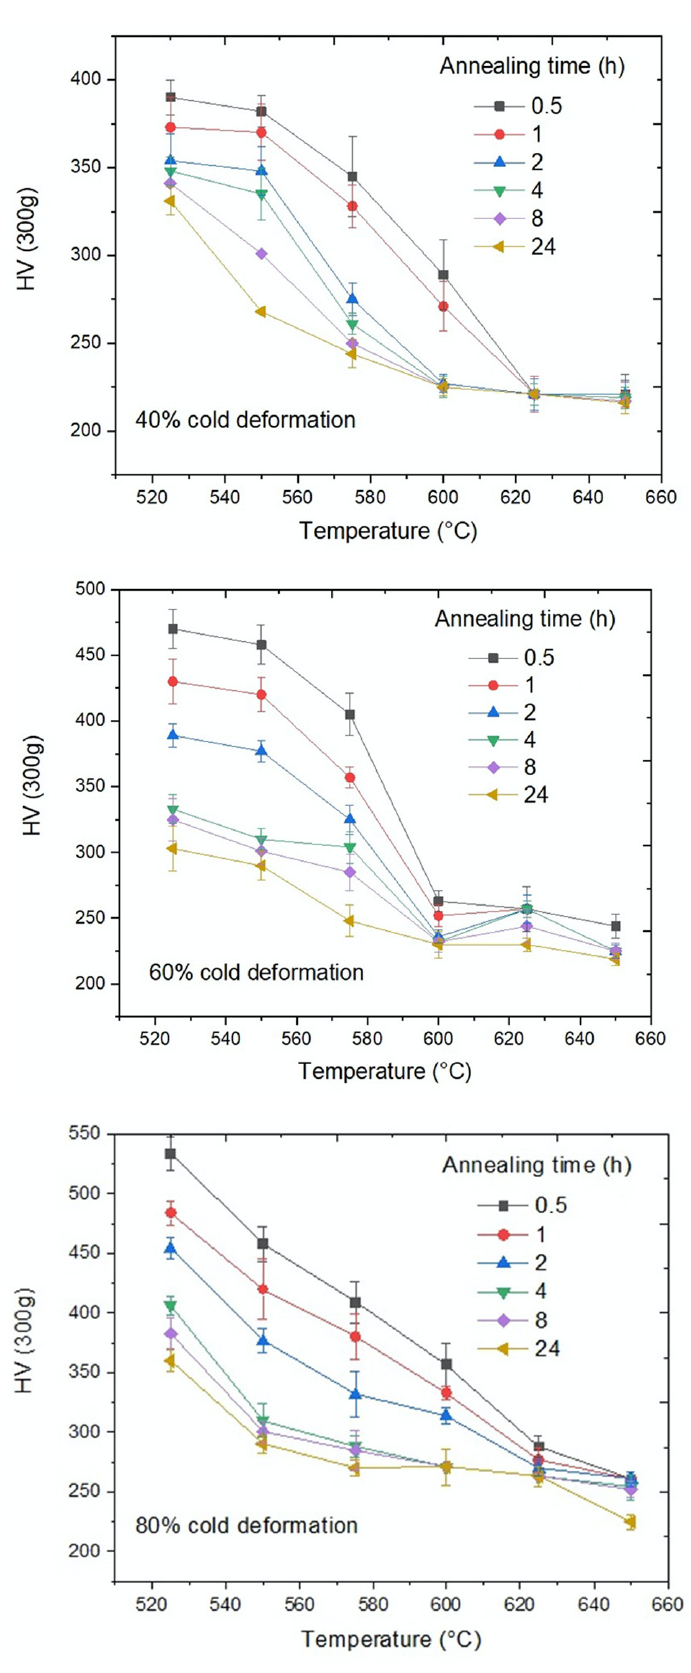
Figure 12. Vickers microhardness of Austenite vs. annealing temperature for different times.